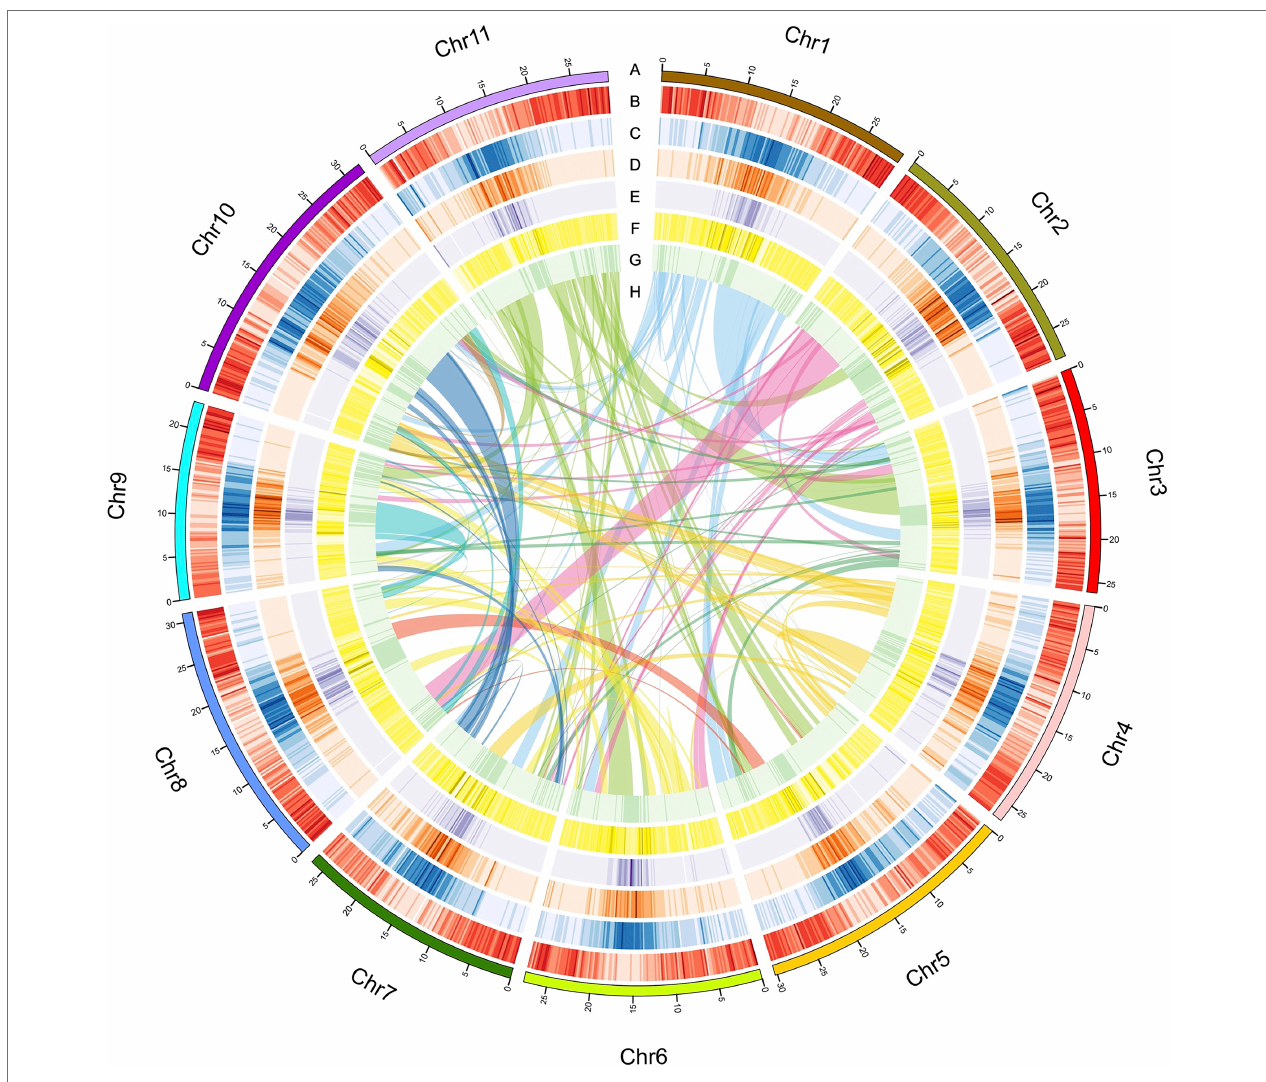
FIGURE 2 | Characteristics of the A. edgeworthii genome. (A) Chromosome length; (B) Gene density per chromosome; (C) Repeat density; (D) LTR_Copia density; (E) LTR_Gypsy density; (F) SNP density in 5 populations; (G) Distribution of the GC content; (H) Intra-genome collinear blocks connected. All statistics are computed for windows of 200